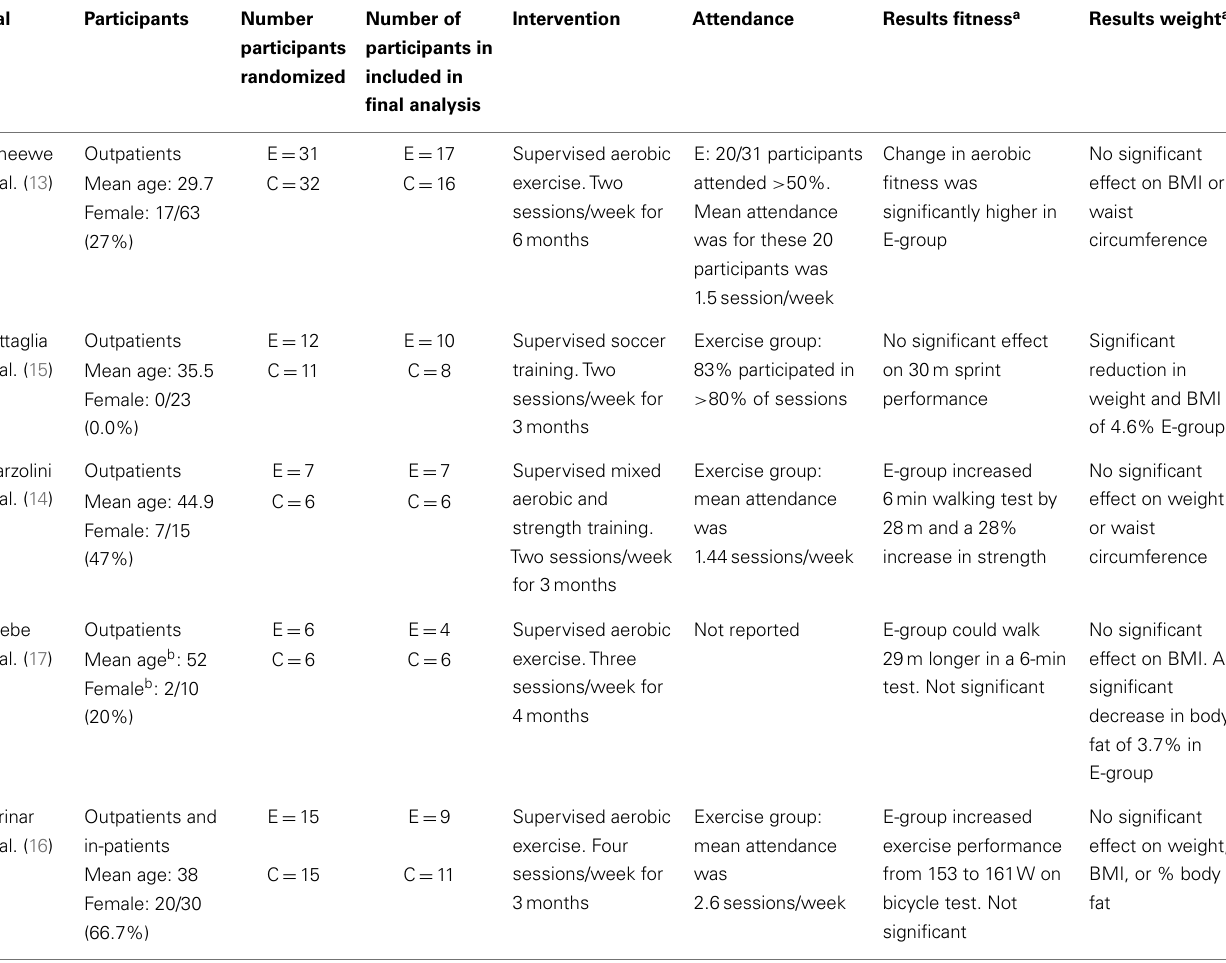
Table 1 | Randomized clinical trials investigating the effect of exercise interventions in patients with schizophrenia .